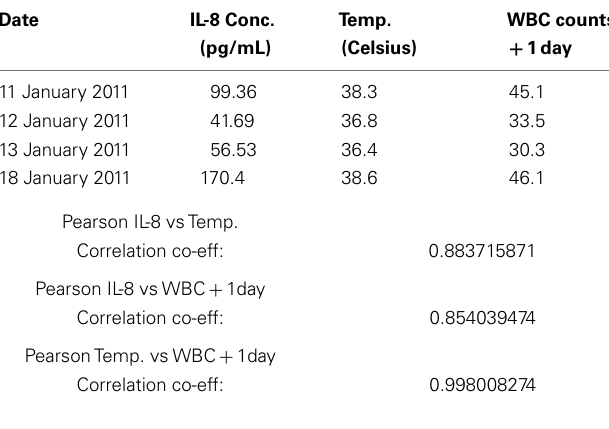
Table 2 | Calculation of Pearson correlation coefficients for the relation of temperature, white blood cell counts, and interleukin 8 (IL-8) plasma